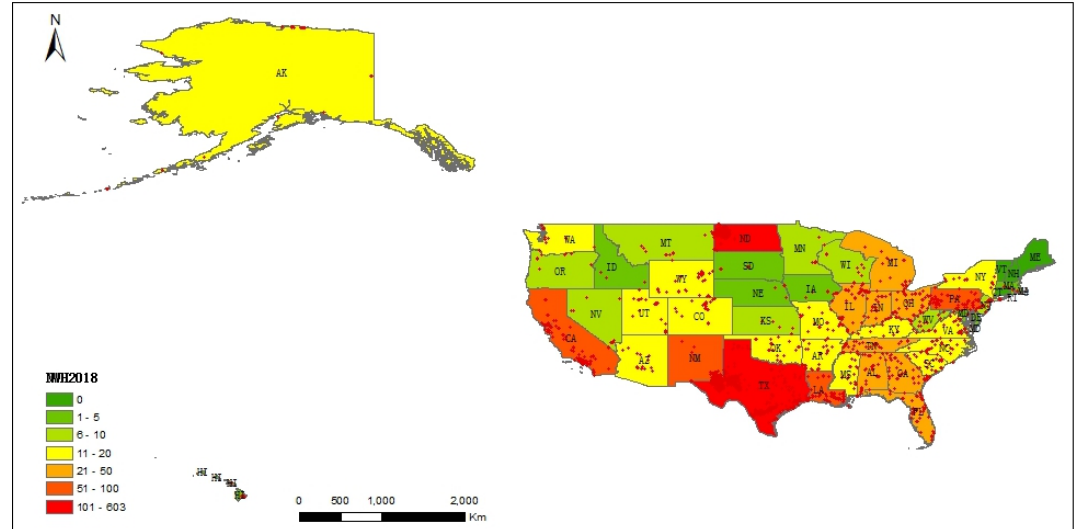
Figure 9. Distribution patterns of working industrial heat releasers in different states in the US (2018).